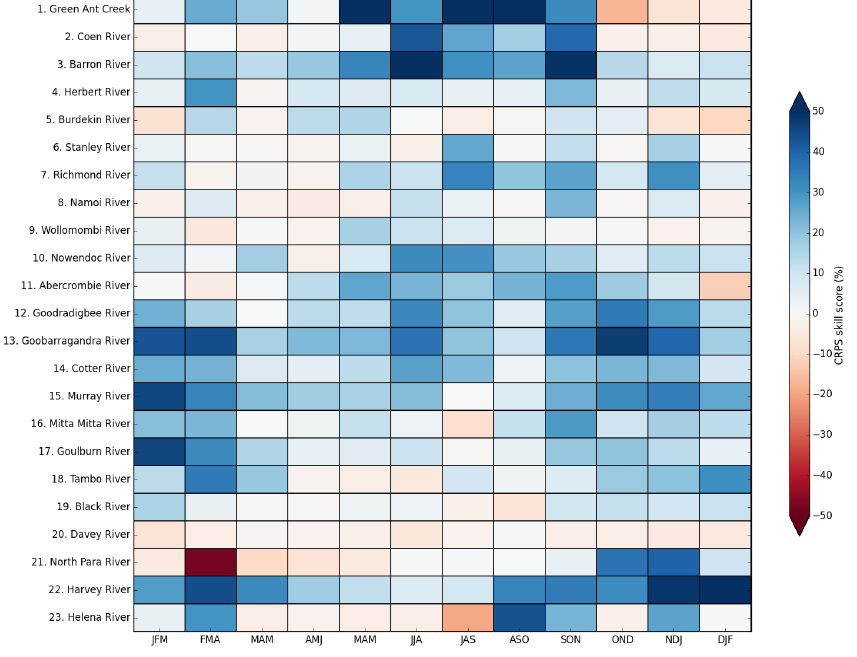
Figure 5. CRPS skill scores for each catchment and target season at 7-day lead time. Skill scores are relative to climatology. Leave-five- years-out cross-validation is applied for the period